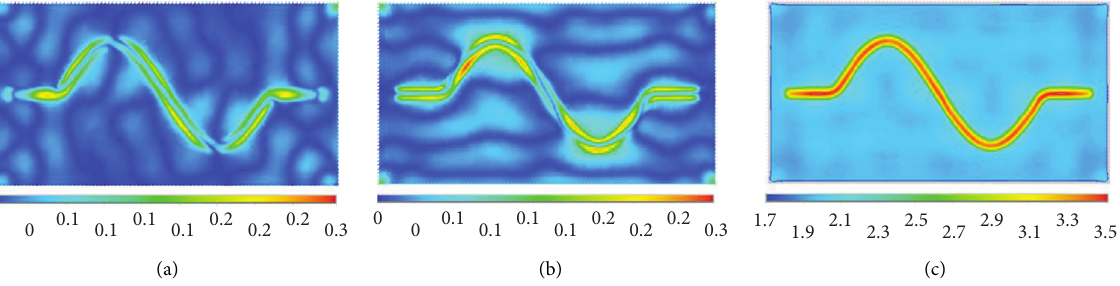
u u x , (b) y , and (c) z .